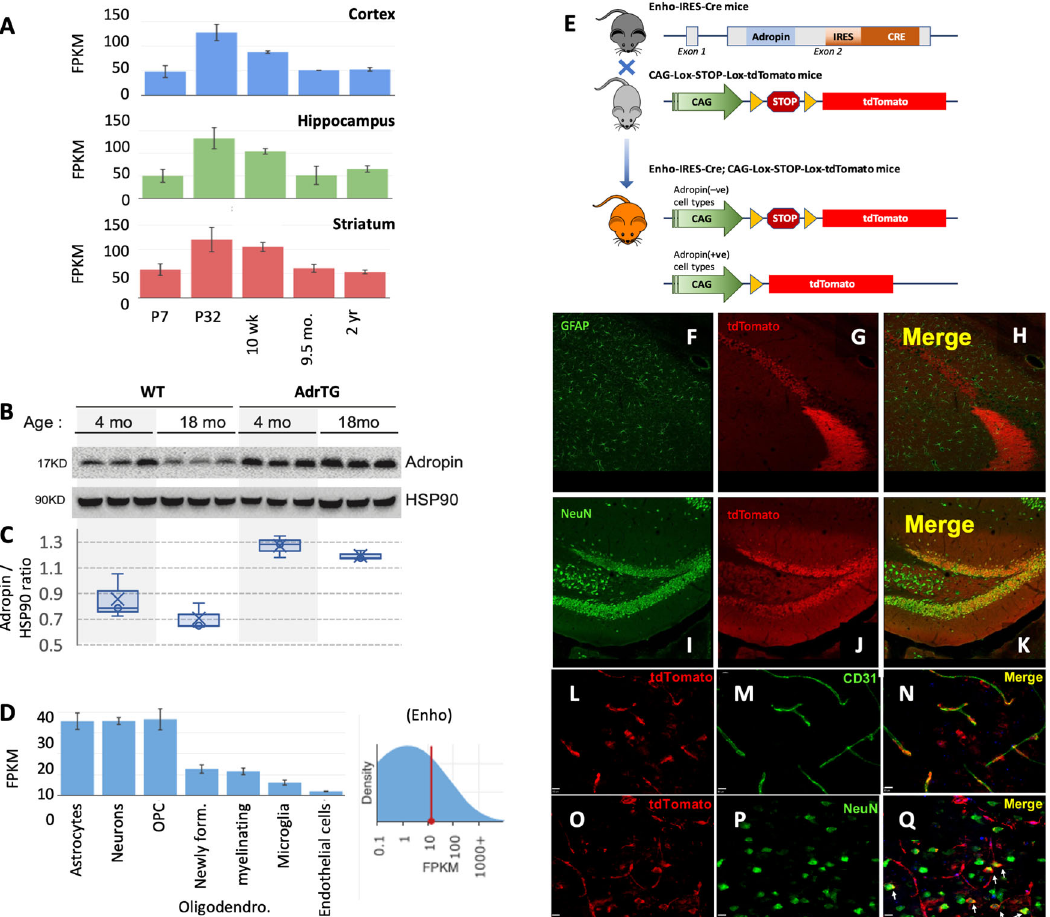
Fig. 6 Adropin expression in the mouse brain. A Expression pro fi ling in mouse brain structures by age show a peak at postnatal day 32 (P32). B , C Adropin immunoreactivity in brain lysates of AdrTG mice compared to wild type (WT) littermates at 4 and 18 months of age. WT mice show a decline in adropin protein levels at 18 months that is not observed in AdrTG. HSP90 was used as a loading control. D Pro fi ling of Enho expression in isolated cells from the mouse brain. E The top panel is a schematic of the approach used to generate an ENHO-Cre reporter mouse. The lower panels ( F – Q ) are representative photomicrographs from hippocampal sections ( F – K ) and high magni fi cation photomicrographs of vessels in the cortex ( L – Q ). Scale bars (10 μ M) are shown in the bottom left in ( L – Q mice indicated WT mice were more prone to weight loss during (O, 16 – 20 mo.). The respiratory exchange ratio (RER, VCO 2 /VO 2 ) recordings ( − 2.4 ± 3.0 vs. − 0.6 ± 0.8, p < 0.05). Advanced age may provides an estimate of whole body substrate selection 68 . The RER exacerbate the phenotype (Fig. S6F). increases during the dark period as chow-fed mice move to Ambulatory movement exhibited the predicted diurnal pro fi le, oxidizing ingested carbohydrates and relying less on mobilized irrespective of age or sex or genotype (Fig. S6G, H). Aging of WT fatty acid (Fig. S6A, B). WT-O mice exhibited low RER, indicating mice, but not in AdrTG mice, appeared to associate with reduced increased dependency on fat reserves (Fig. S6A). In females, the movement (Fig. S6G-I). A negative energy balance indicated by RER transition between light and dark periods was more low food intake and weight loss might be predicted to account for pronounced in AdrTG, irrespective of age (Fig. S6B). Oxygen this phenotype. Food intake is a strong predictor of weight gain/ consumption exhibited the diurnal rhythm predicted from loss (Fig. S7A). However, it is not a strong predictor of ambulatory increased ambulatory activity and food intake during the dark period (Fig. S6C, D). This feature of energy metabolism was not markedly affected by genotype. Food intake and changes in body weight during the recordings were consistent with RER data, indicating improved maintenance of body weight in M and old-AdrTG mice. Male WT-O mice lost weight during the recording (mean ± SD and n for weight gain/ loss in g, young-WT − 0.1 ± 0.2, n = 4; old-WT − 5.8 ± 3.4, n = 3; young-AdrTG − 0.4 ± 1.0, n = 4; old-AdrTG − 1.7 ± 0.5, n = 3). Female WT mice also tended to lose more weight (mean ± SD for weight gain/loss in g, young-WT − 3.0 ± 2.5; old-WT − 1.6 ± 2.9; young-AdrTG − 0.1 ± 0.5; old-AdrTG − 0.6 ± 0.5, n = 4 all groups). Weight loss correlated with lower food intake during the recording period (Fig. S6E). Pooling data from male and female